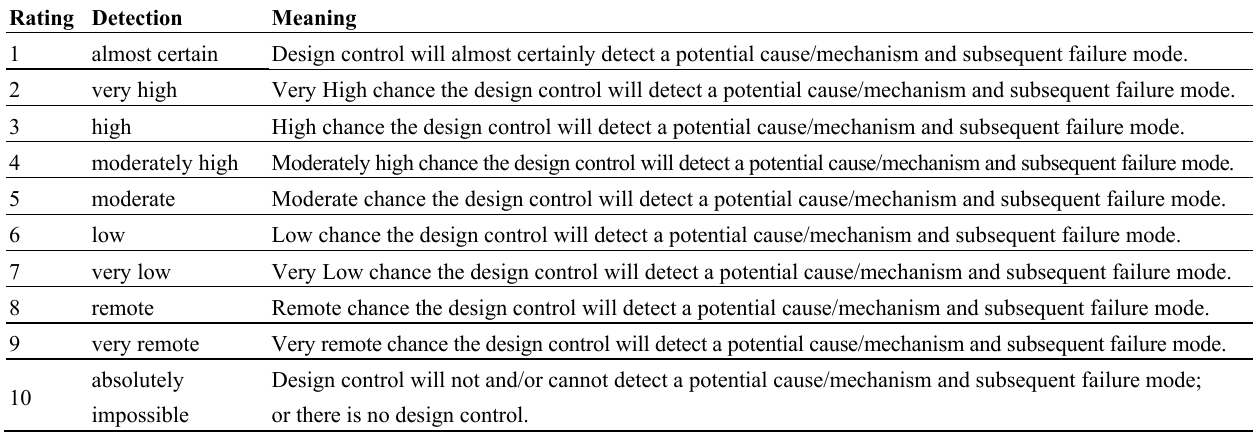
Table A3. FMEA ratings for detection of a failure ( D )